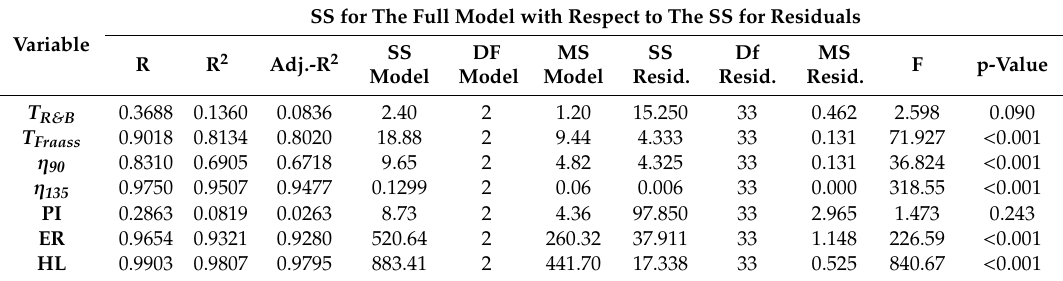
Table 13. Parameters of the model of the binder properties versus